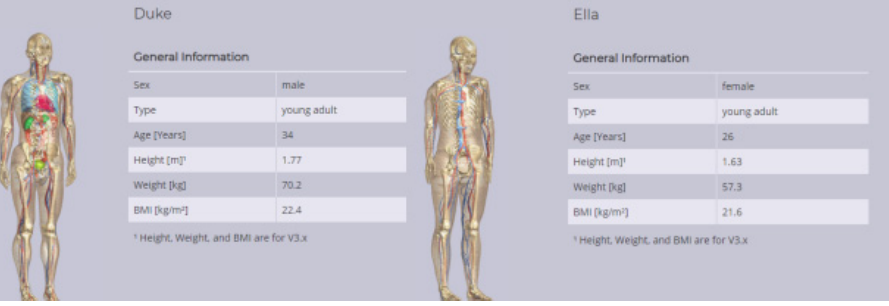
Figure 20 . Selected anatomical models from the ViP3.1 virtual population .